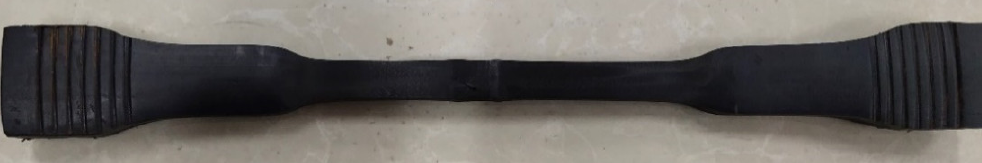
Figure 6. Creep failure specimen of HDPE without welding bead and welding defect under a load of 10 MPa and at a temperature of 28 °C.